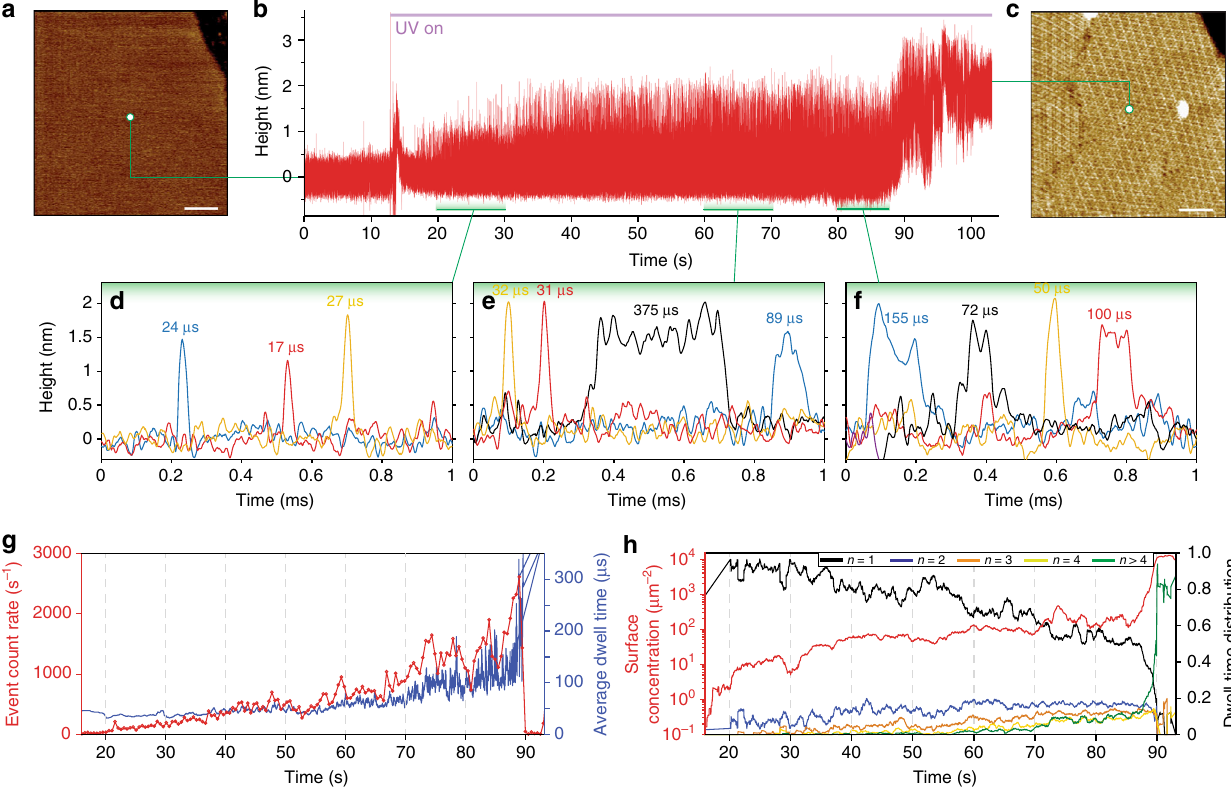
Fig. 4 Time-lapse HS-AFM-HS of annexin-V membrane-binding and self-assembly. a HS-AFM image taken before A5 membrane-binding and self- assembly (bare lipid bilayer). b HS-AFM-HS height/time trace during illumination with UV-light to release Ca 2 + . c HS-AFM image taken directly after b ( p 6-lattice 2D-crystals). d – f Show higher temporal resolution zoom-ins of the HS-AFM-HS trace ( b ) showing example diffusion events from the 20 – 30 s, 60 – 70 s and 80 – 87 s time regions, respectively, with different line colors representing different events. g Number of single diffusion events (red) and averaged dwell-times (blue) over time. h Overall surface concentration (red) and oligomer species (black: A5, blue: A5 2 , orange: A5 3 , yellow: A5 4 , green: A5 O ) distribution changes over time. Traces in d , e are averaged over 1 s time-windows (time scale panels c , d and e are matched). Scale bars: 50